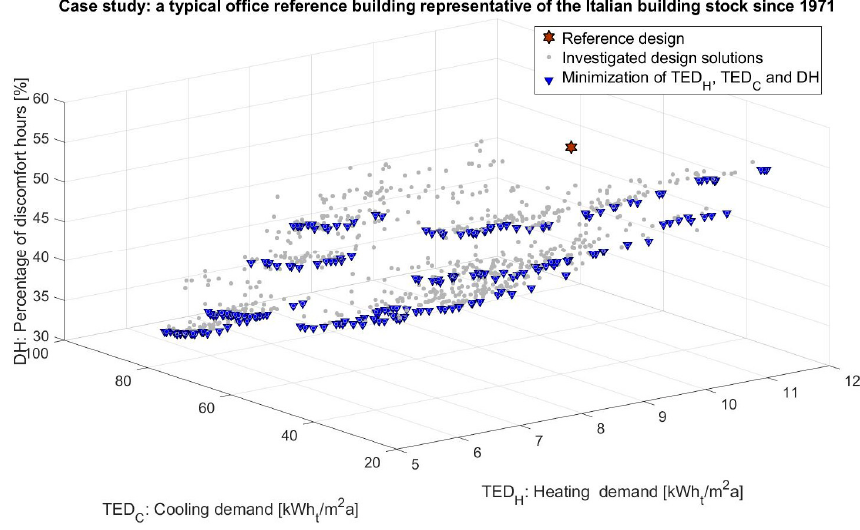
Figure 6. 3-D Pareto front.